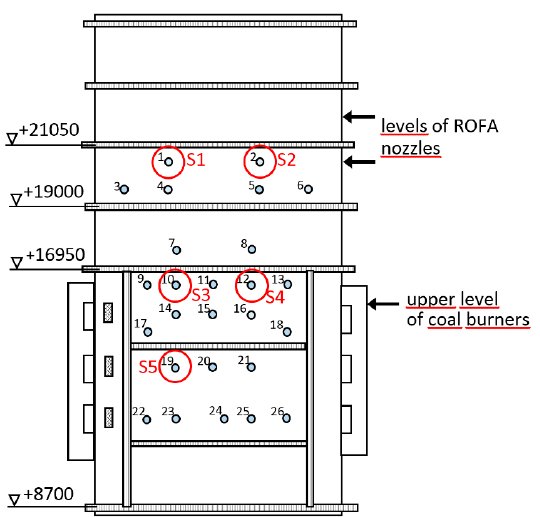
Figure 1. View of location points for measuring the flue gas composition in the boundary layer of the OP230 boiler.